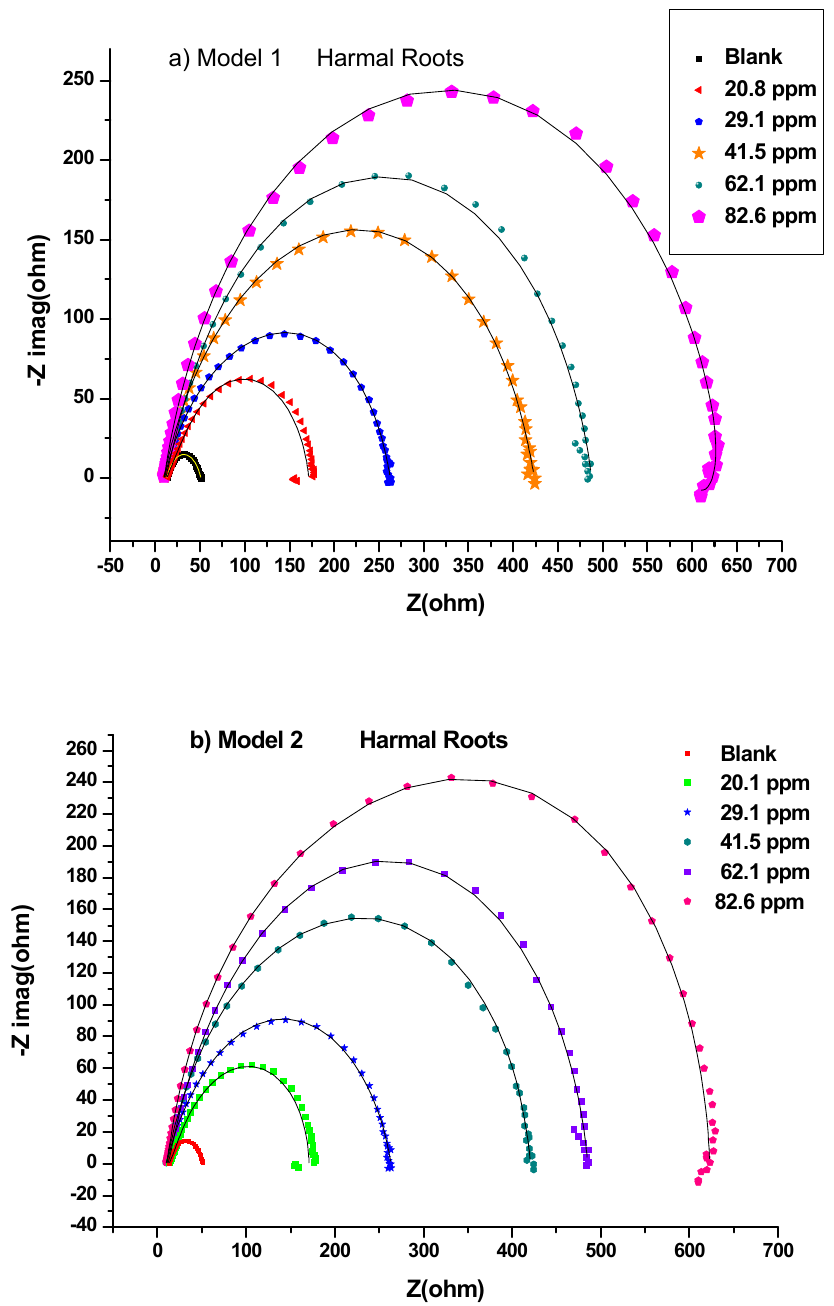
Figure 3. Nyquist plots for all concentrations of Harmal roots extract inhibitors in 0.25 M H 2 SO 4 at 298 K fitted by ( a ) Model 1 and ( b ) Model 2.